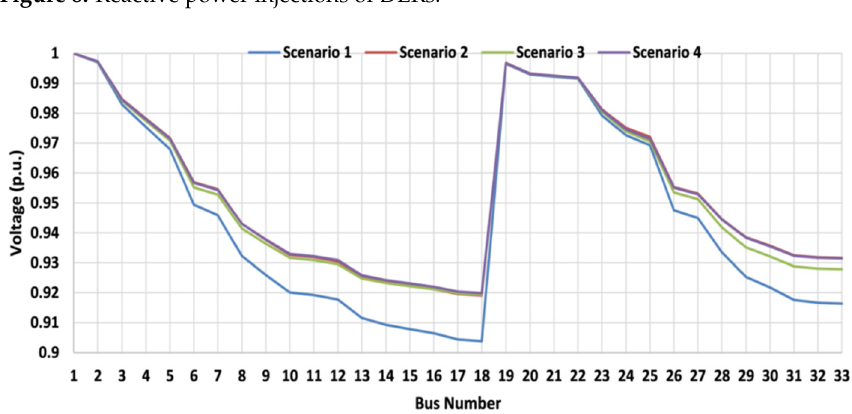
Figure 9. The comparison between voltages of four scenarios. Table 5. The comparison of the proposed method with other